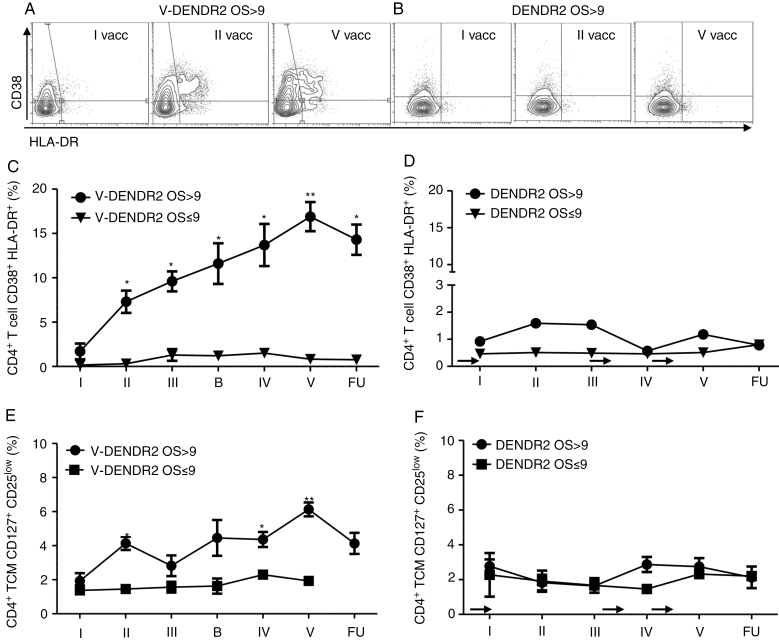
(A and B) Kinetics of the frequency of CD38+/HLA-DR+-activated cells evaluated in CD45/CD3/CD4+ T cells, after in vitro restimulation, in V-DENDR2 (A) (*P < .01, ** P < .005 vs. I vaccination; Mann-Whitney test) and DENDR2 patients (B); (C and D) Time course of CD4+ CD127+ CD25low T-cells analysis in V-DENDR2 (C) (*P < .01, **P < .005 vs. I vaccination; Mann–Whitney test) and DENDR2 patients (D). The arrows indicate the TMZ administrations. TMZ, temozolomide.